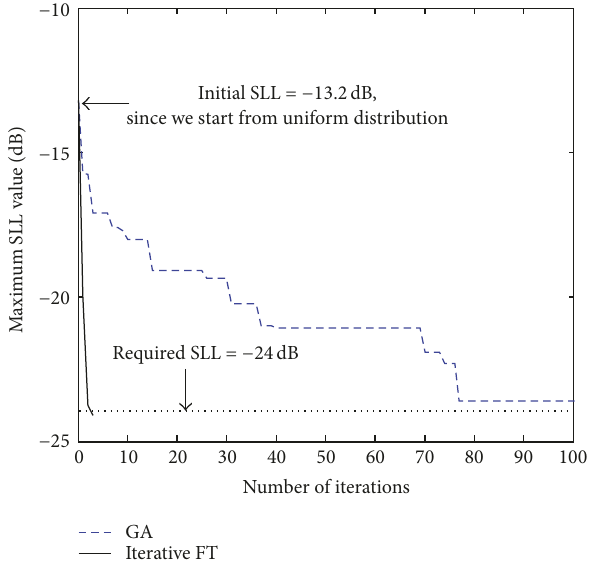
Figure 4: Variation of the maximum sidelobe level versus the number of iterations for the sum pattern.